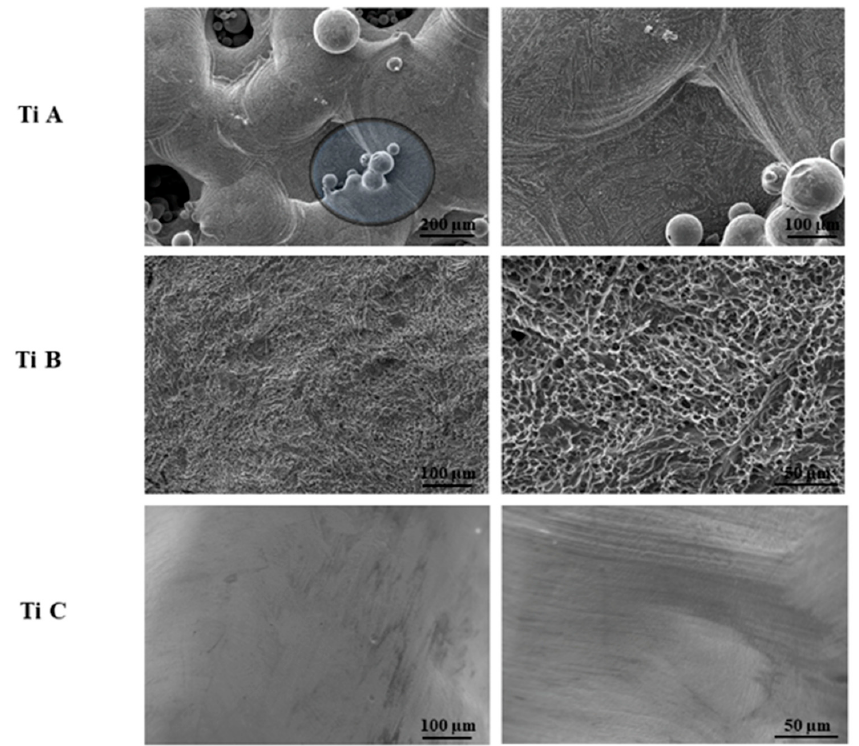
Figure 1. SEM images of Titanium A, Titanium B and Titanium C surfaces. Magnification: Titanium A 200× left image, 500× right image, Titanium B and C 500× left image, 2000× right image.